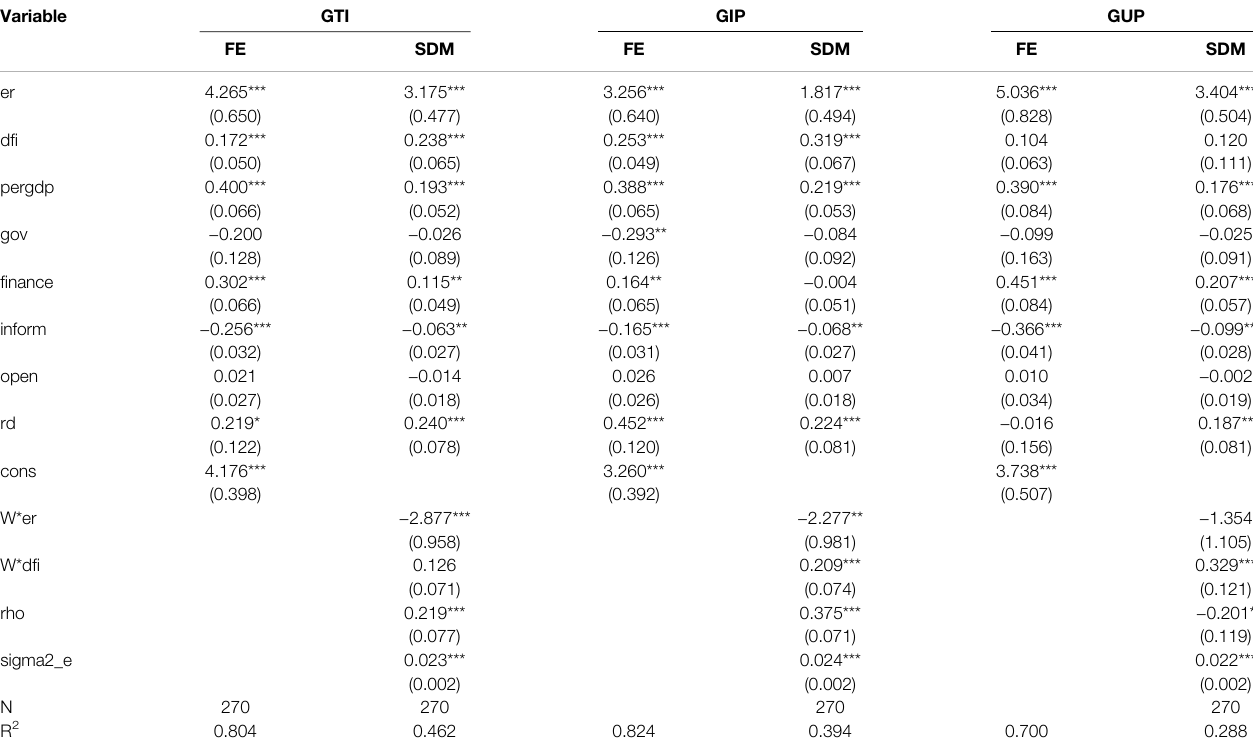
TABLE 3 | Estimation results of the basic model. Variable